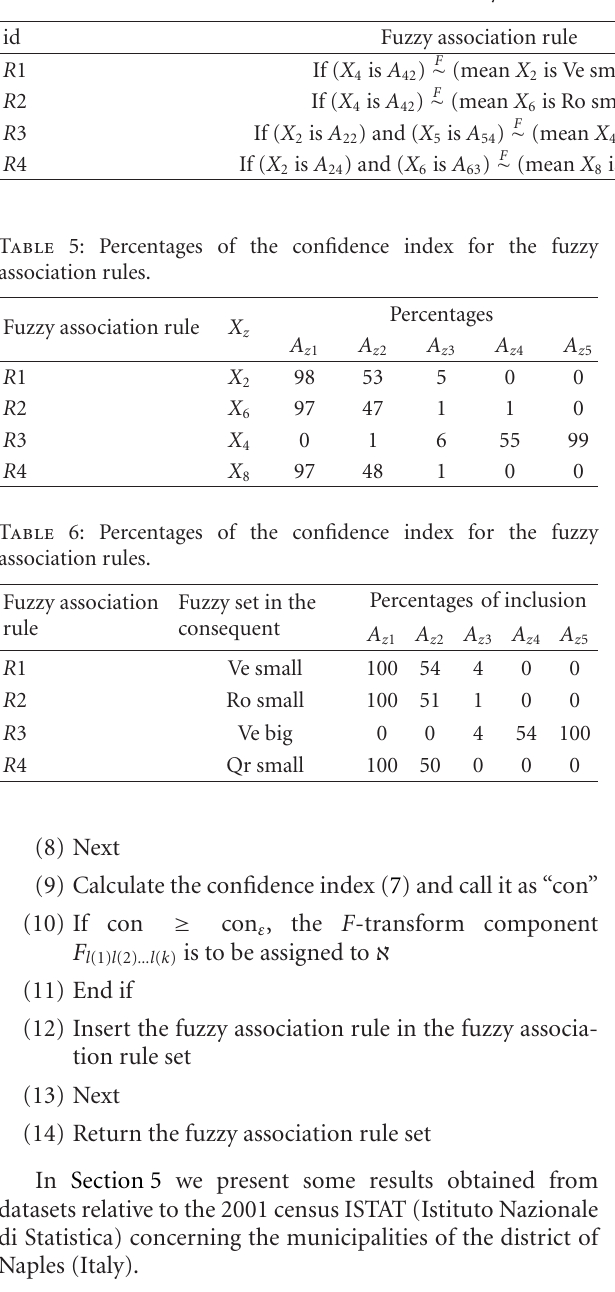
Table 4: Fuzzy rules extracted from the resident dataset.